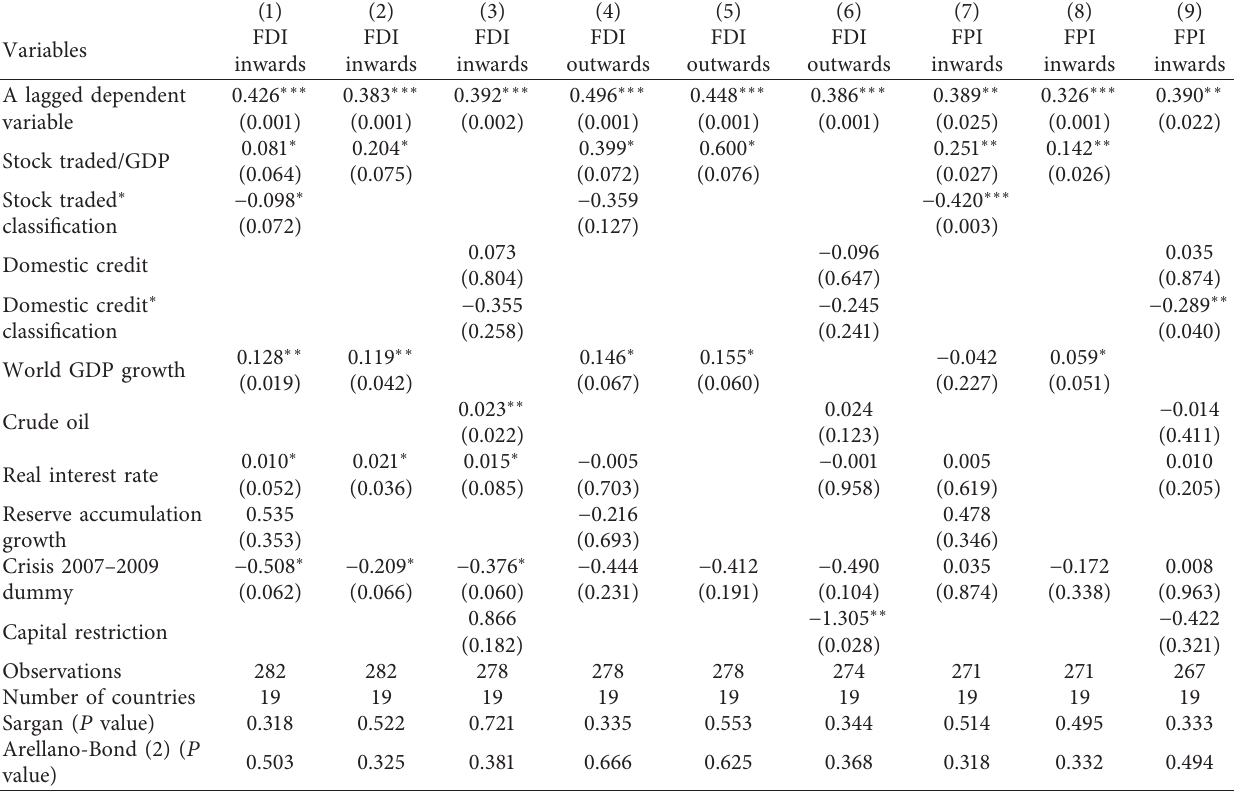
Table 6: Results of system GMM in G20 countries.